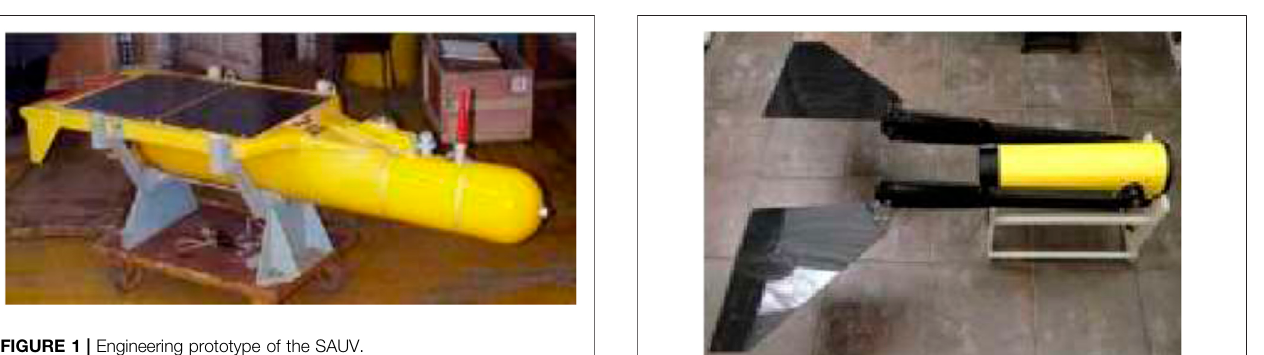
FIGURE 1 | Engineering prototype of the SAUV.